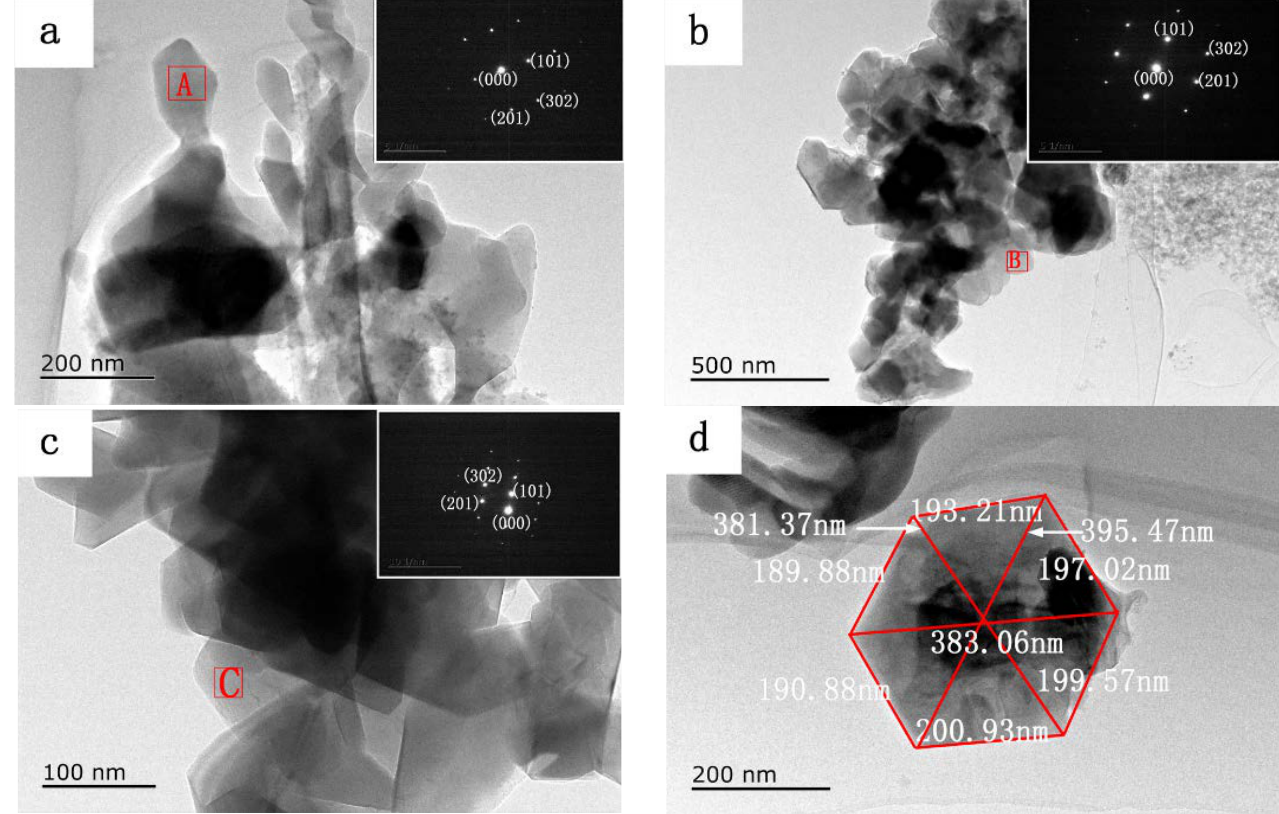
Figure 5. TEM images and SAED patterns (insets, area of A, B, and C) of samples containing obtained using catalysts. ( a ) 2 wt% Fe, ( b ) 2 wt% Co, ( c ) 2 wt% Ni, ( d ) an individual α -Si 3 N 4 hexagonal plate in the sample obtained using Ni as the catalyst.